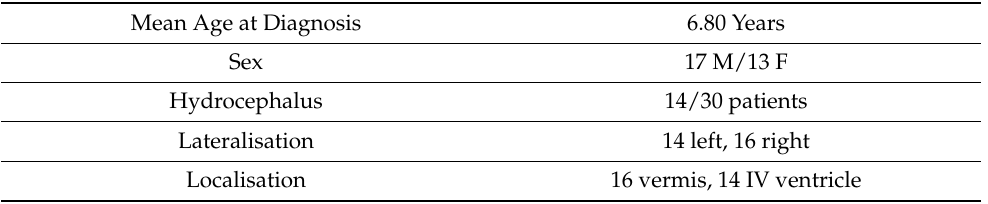
Table 1. Patients’